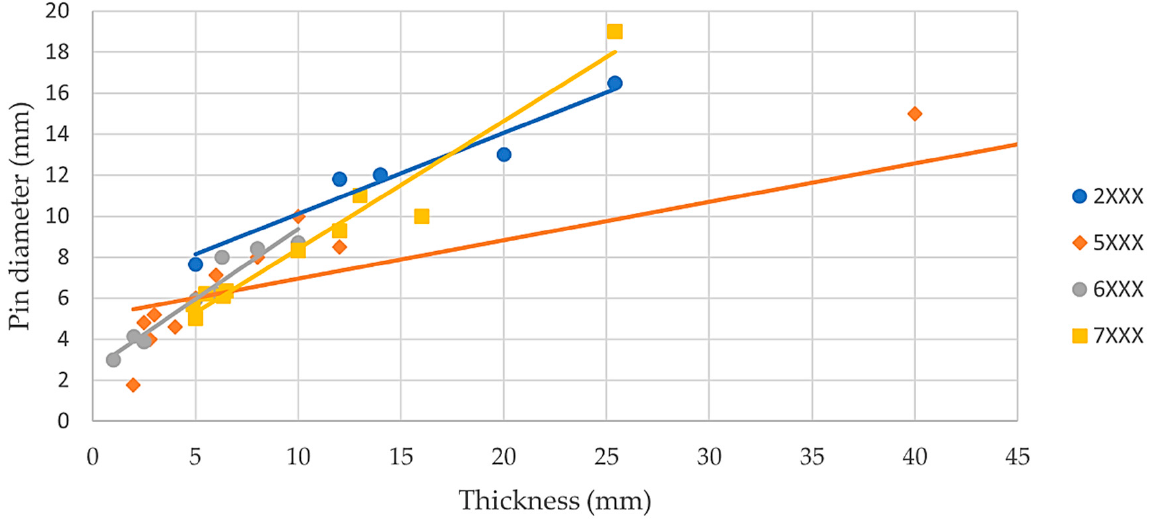
Figure 4. Summary of trend lines for pin diameter vs. thickness.